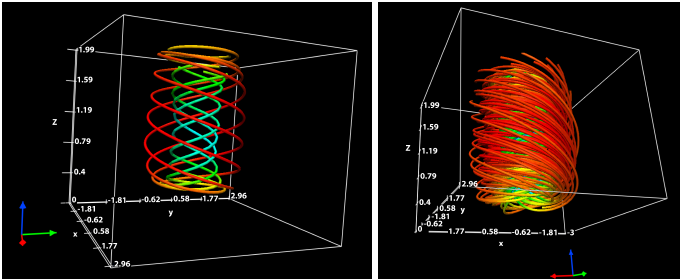
Figure 1. The normalised three-dimensional stream lines of the vortex velocity field. On the left panel only four stream lines are shown. The light blue and green colours of the stream lines correspond to the internal structure of the vortex. The red and amber colours correspond to the external part of the vortex. On the right panel more than forty velocity stream lines are shown. The red, green and blue orthogonal vectors colours indicate the x , y and z axis, correspondingly. The visualisation was computed for r 0 = 1 and L =